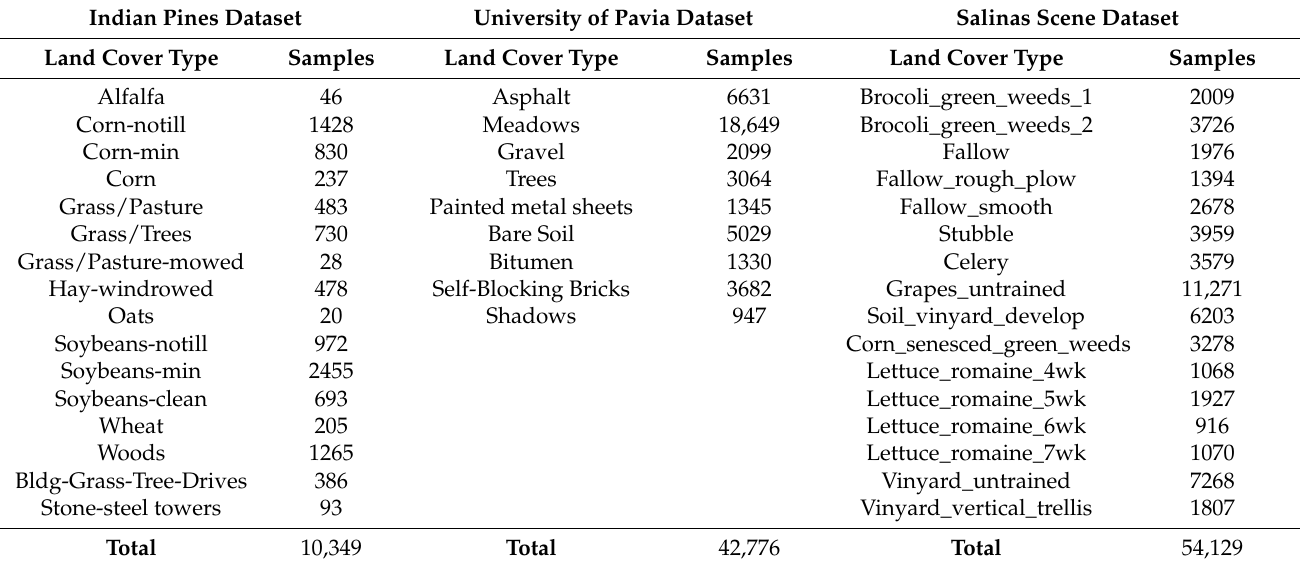
Table 2. Details of Indian Pines, University of Pavia, and Salinas